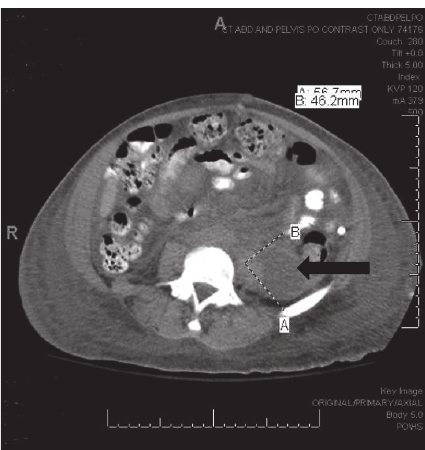
Figure 1: Repeat CT scan of the abdomen and pelvis with an ovoid fluid collection which measures 5.7 × 4.6cm in the axial plane in the left posterior perinephric space.